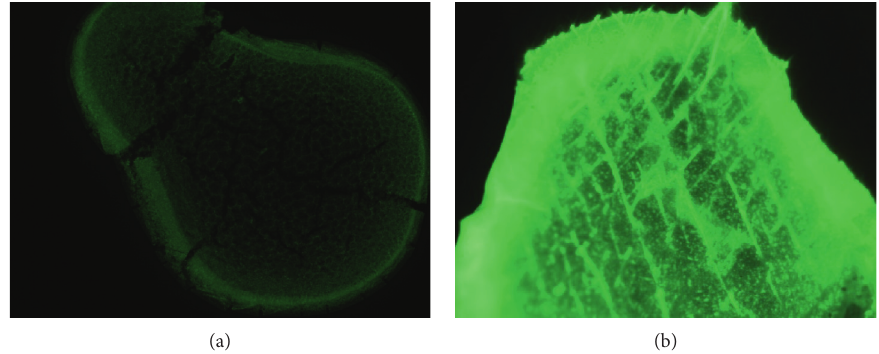
Figure 5: Fluorescence images of PEGDA/SiO